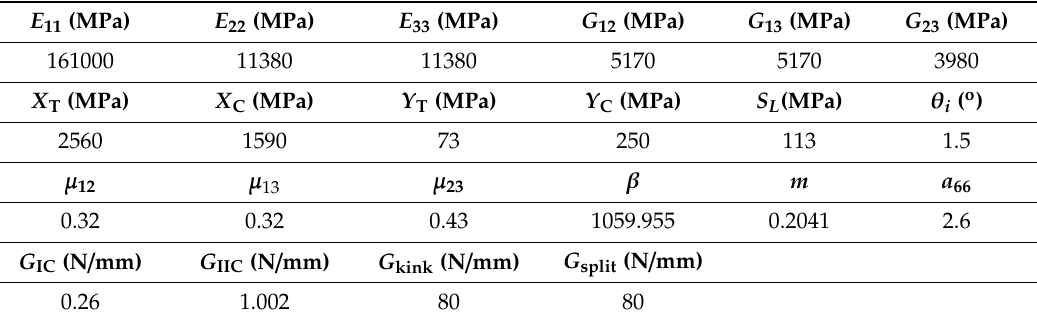
Table 3. Material properties of IM7 / 855 and model parameters [10,22].